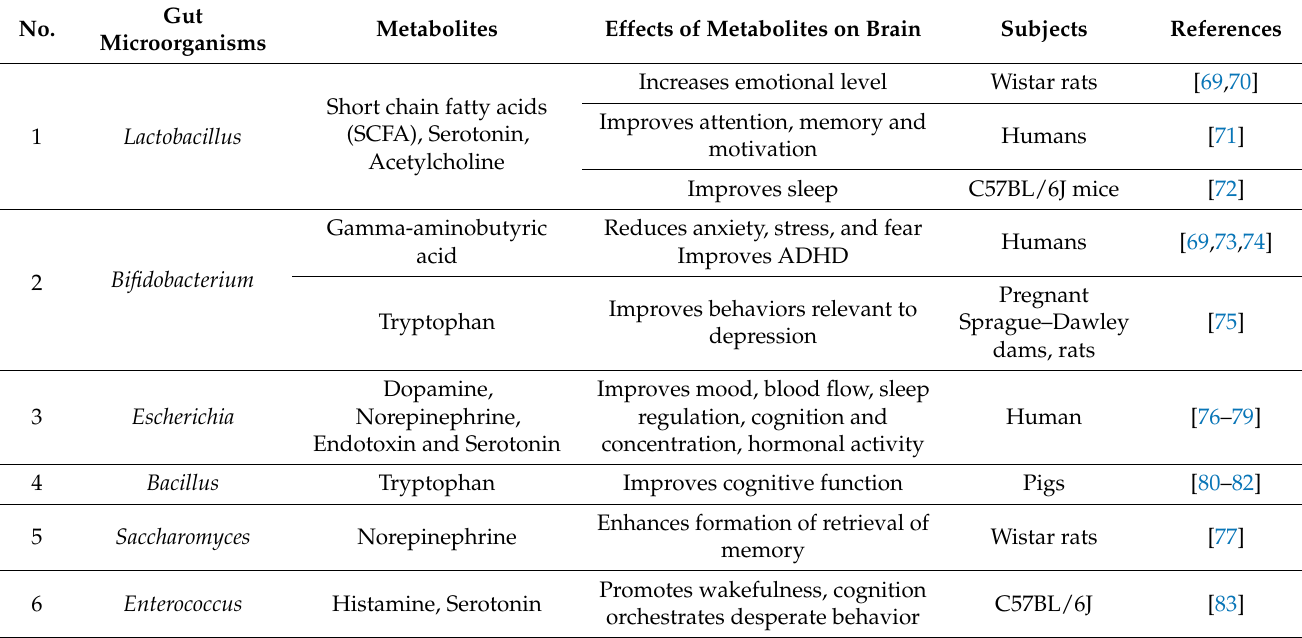
Table 1. Effect of metabolites on brain produced by gut